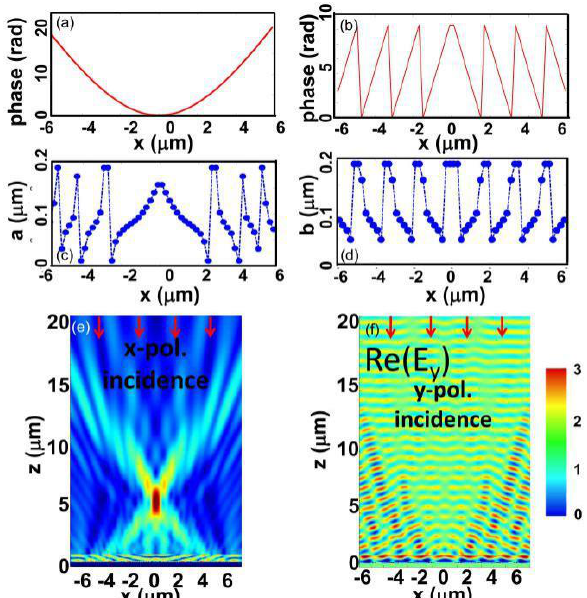
Figure 6. Phase profile ( a ) to focus incident light for x-polarization incidences and ( b ) to split incident light y-polarization incidences. Corresponding lengths of ( c ) x-direction length a and ( d ) y-direction length b of the rectangle antenna in metalens design. ( e ) The electric field intensities for x-polarization incidence. ( f ) The real part of y-component electric distribution for y-polarization incidence.